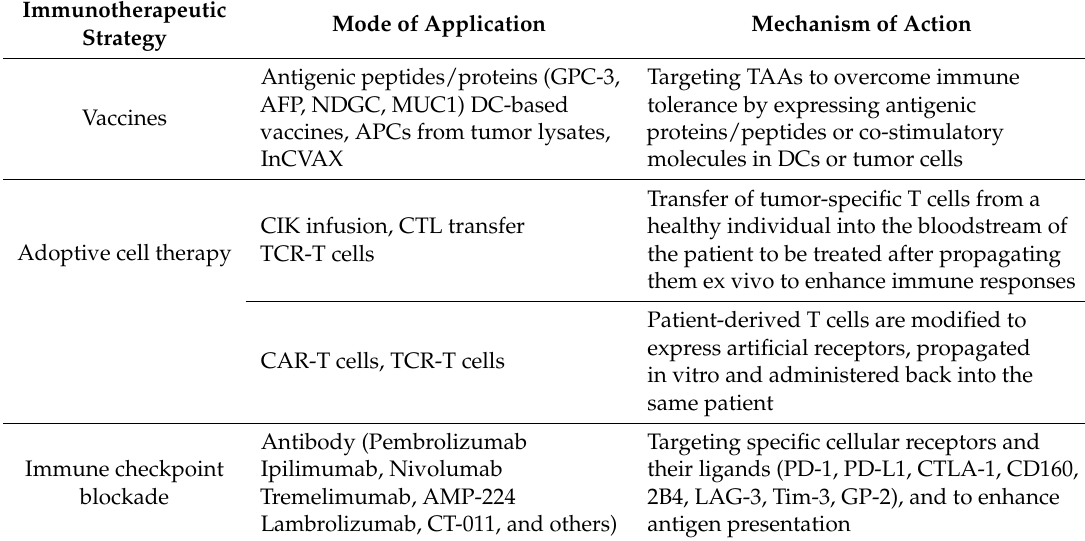
Table 1. Some of the immunotherapeutic strategies currently used in clinical trials to treat liver cancer.